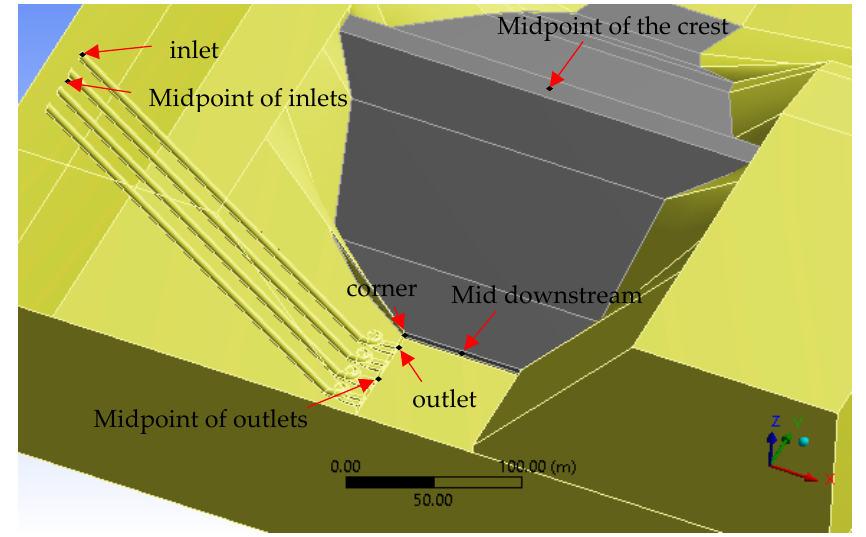
Figure 8. The model of the Temenggor dam body and four turbines with stress measurement points.